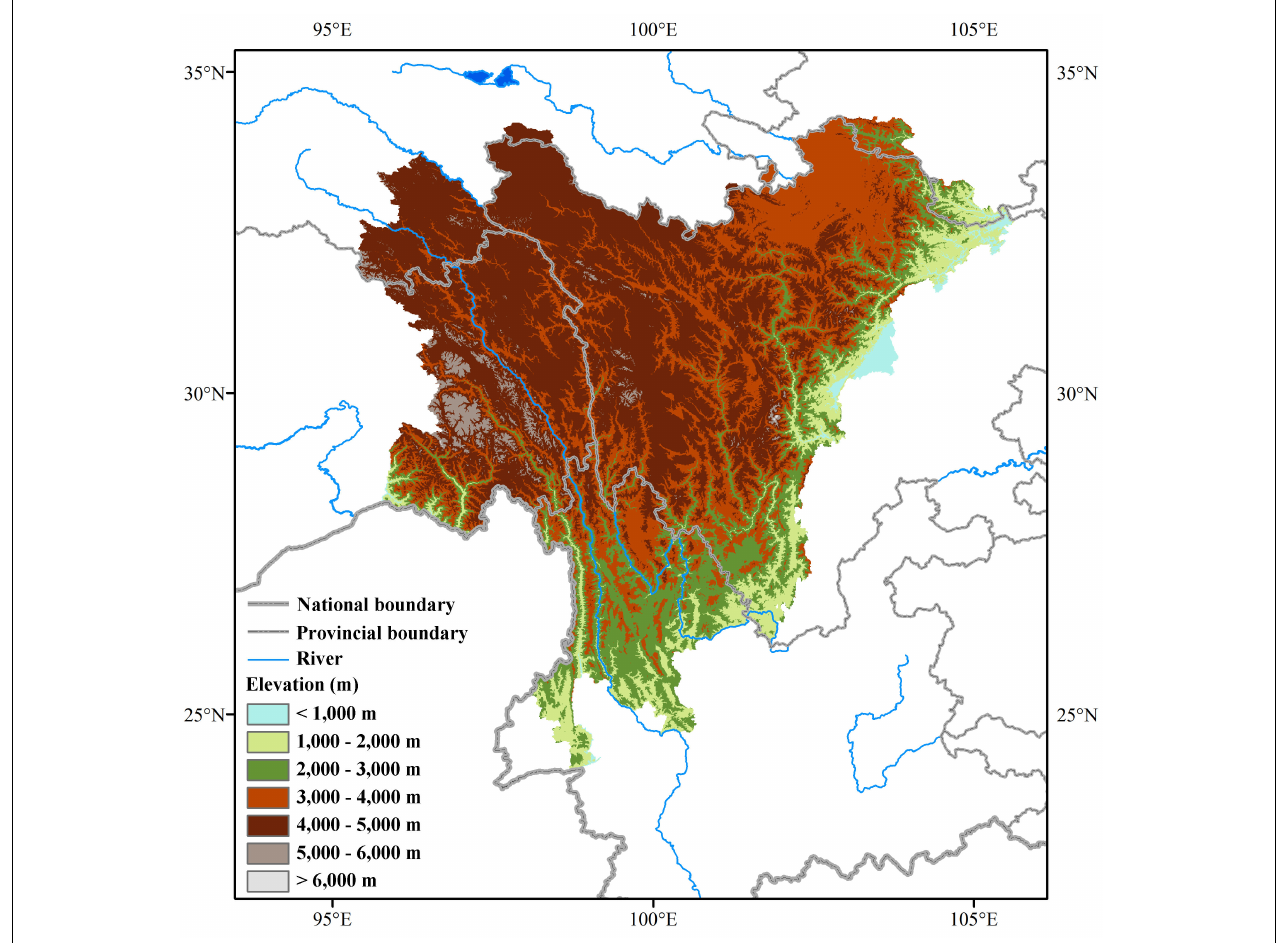
FIGURE 1 | The location of the Hengduan Mountains in southwestern